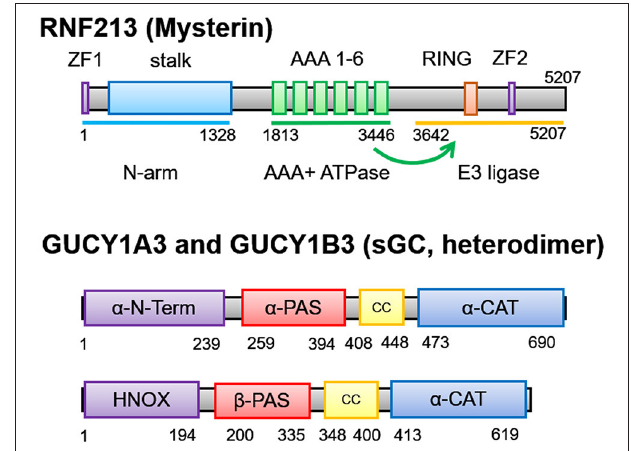
FIGURE 1 | Molecular structure of RNF213 and soluble guanylate cyclase (sGC) encoded by GUCY1A3. RNF213 consists of N-arm, AAA + ATPase, and E3 ligase. E3 ligase contains two different types of zinc finger, RING and ZF2 (NFX1-type zinc finger). Not only mutations in the RING and ZF2, but also mutations in the AAA + ATPase may disturb the function of E3 ligase. GUCY1A3 and GUCY1B3 encode the α 1 and β 1 subunits of soluble guanylate cyclase (sGC) to form a